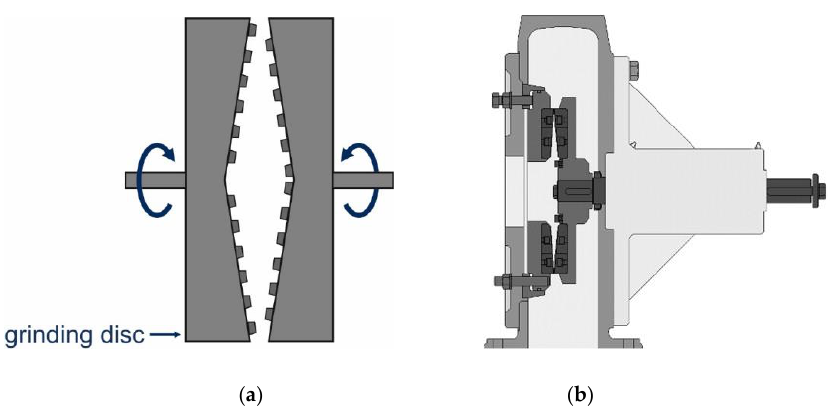
Figure 1. Schematic showing the principle of action ( a ) and schematic representation of a disc mill ( b ). Reproduced with permission from Roland Nied, Handbook of Powder Technology; published by Elsevier, 2007 [32].